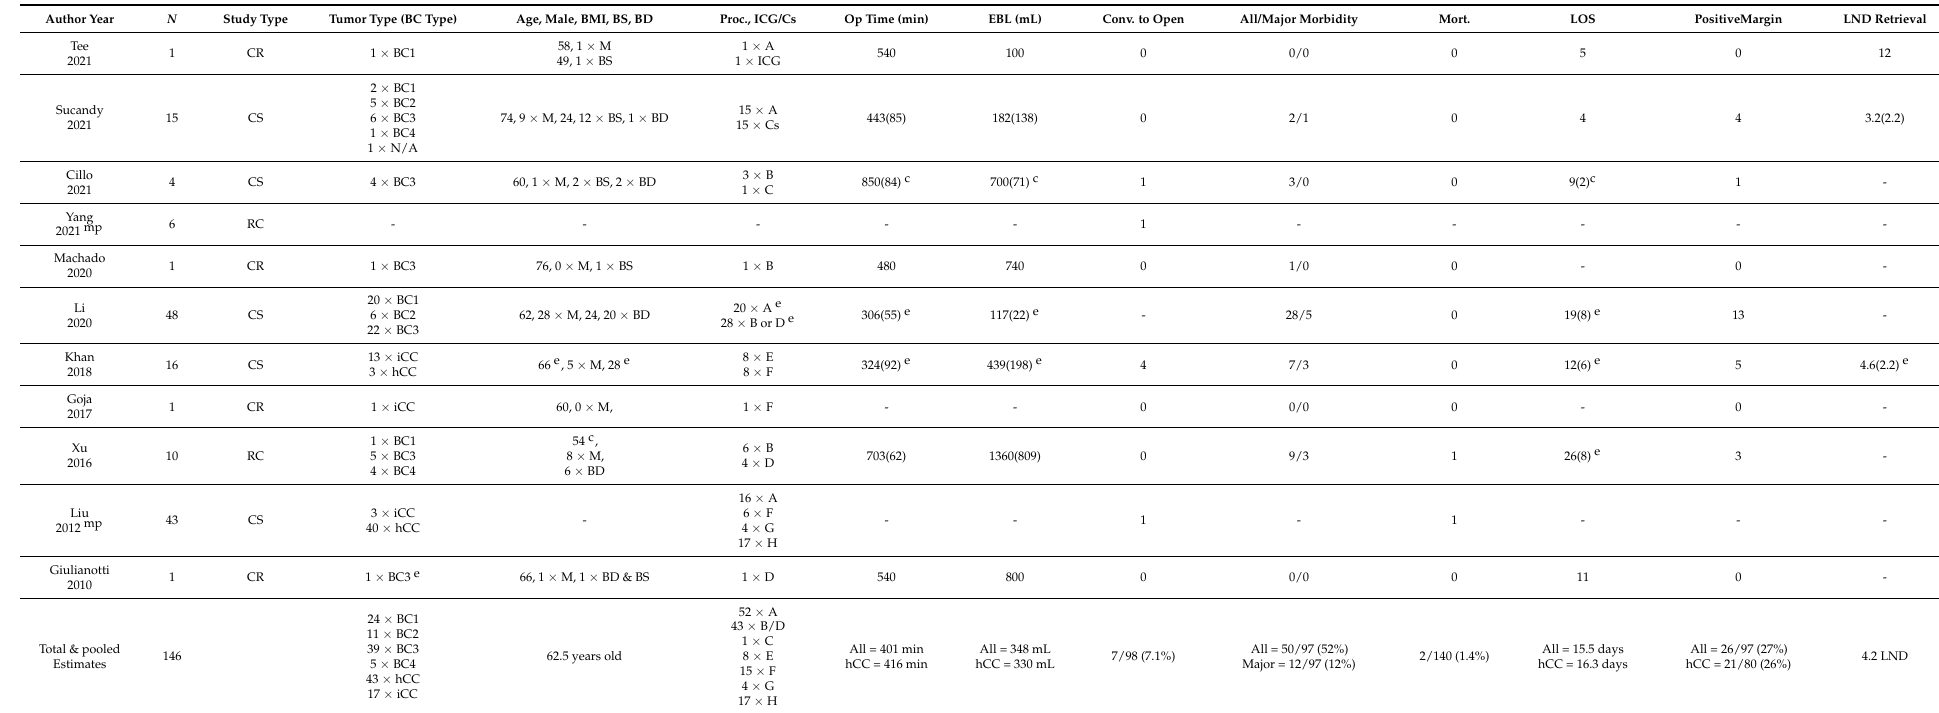
Table 1. Systematic review of robotic